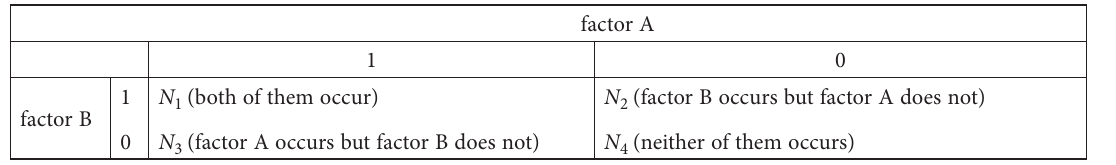
Table 3. Brief description of HFACS causal